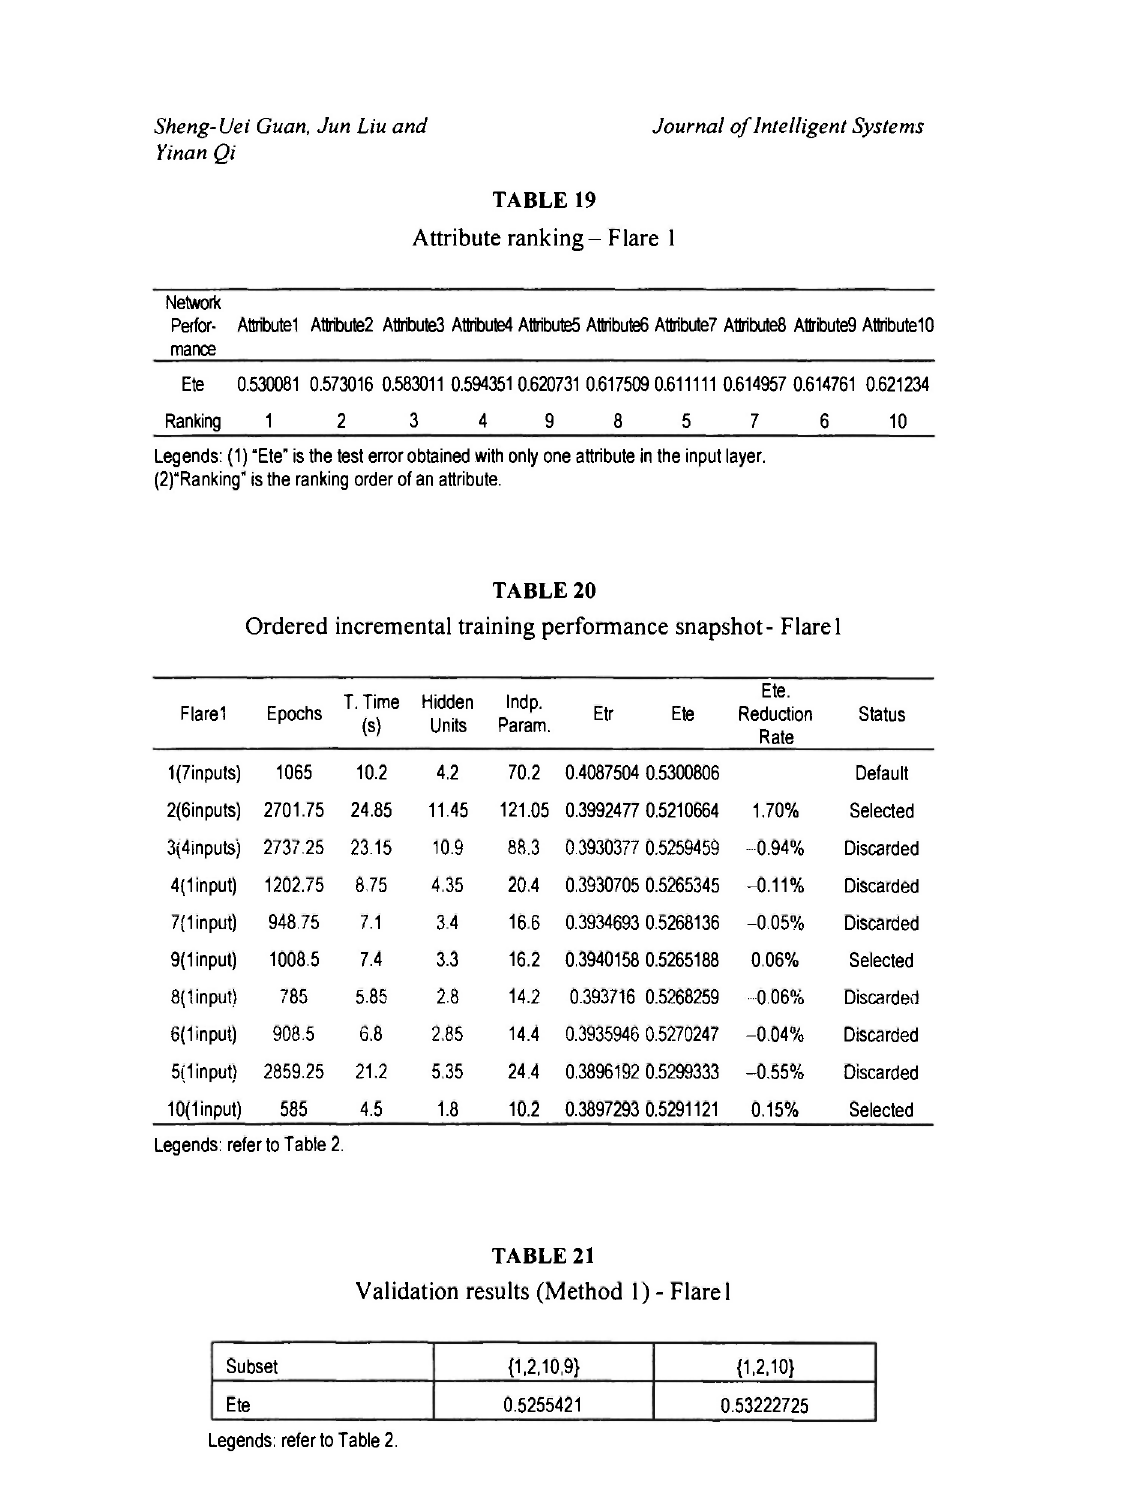
Attribute ranking - Flare 1